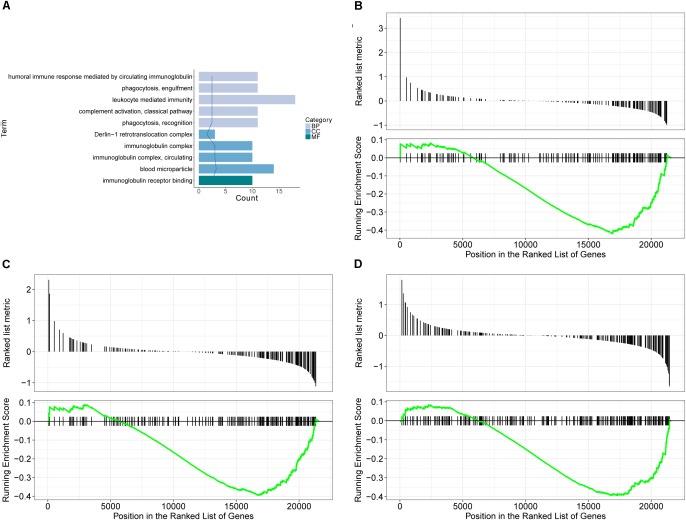
Transcriptomics analysis of paeoniflorin on allergic asthma model mouse. (A) GO enrichment analysis of DEGs between Model and Paeoniflorin in BP (Biological process), MF (Molecular function) and Cellular Component (CC). (B–D) GSEA analysis of DEGs between Model and Control: (B) mmu05152: Tuberculosis; (C) mmu04510: Focal adhesion; (D) mmu04060: Cytokine-cytokine receptor interaction.